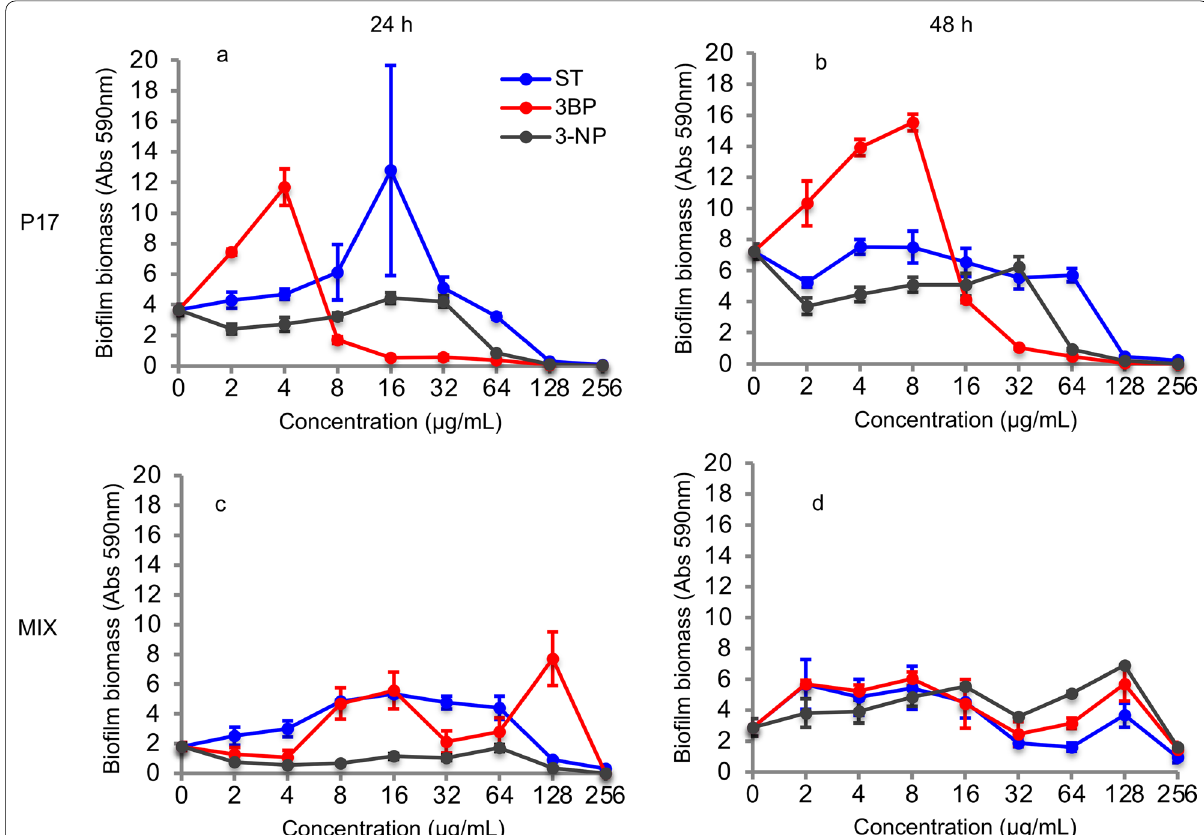
Fig. 4 Biofilm formation of P17 and four species (MIX) cultures with different metabolic inhibitors after 24 and 48 h. a Biofilm formation of P17 culture with different metabolic inhibitors (24 h). b Biofilm formation of P17 culture with different metabolic inhibitors (48 h). c Biofilm formation of four species culture with different metabolic inhibitors (24 h). d Biofilm formation of four species culture with different metabolic inhibitors (48 h). ST: sulfathiazole, 3BP: 3-bromopyruvic acid, and 3-NP: 3-nitropropionic acid, n =